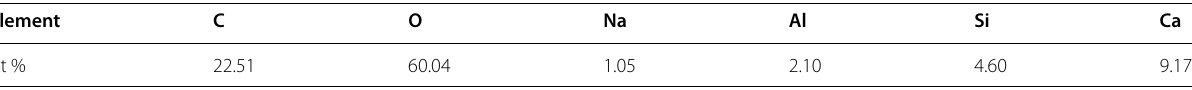
Table 2 EDS element analysis of products in Fig. 4